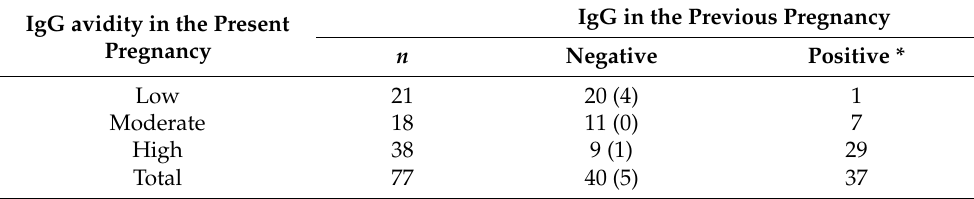
Table 3. IgG antibody positivity in the previous pregnancy according to IgG AI.